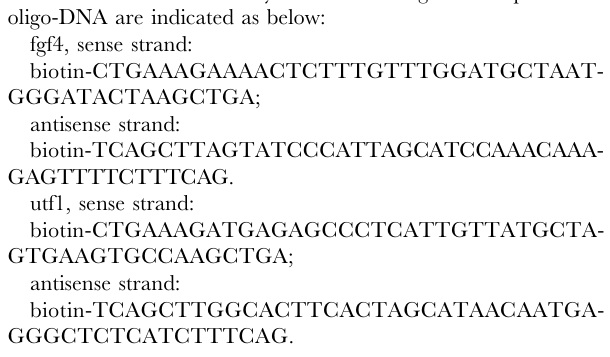
Figure S1 Schematic representation of 8 6 S/O-luc reporter plasmid. 8 6 S/O-luc carries eight copies of tandem fgf4 enhancer elements consisting of neighboring binding sites for Sox2 and Oct3/4. Figure S2 The effect of CARM1 overexpression on the expression of pluripotency-related genes in P19 cells. The relative mRNA levels of pluripotency markers were normalized to Gapdh. Figure S3 The effect of CARM1 knockdown with synthesized siRNA on the expression of pluripotency-related genes in P19 cells. The relative mRNA levels of pluripotency markers were normalized to Gapdh. Control: scrambled siRNA. Figure S4 MS/MS spectrum of the Sox2 peptide EHPDY- KYRdi-methylPR. GST-Sox2 methylated by GST-CARM1 was digested with trypsin and subjected to LC-MS/MS analysis. The MS/MS spectrum of a peptide corresponding to residues 106-115 of Sox2 showed that Arg113 was di-methylated. An asterisk indicates the methylated arginine. Figure S5 Specifically recognition of Sox2 peptide methylated at Arg113, by anti-methyl-Sox2 antibody. Un-methylated peptide KEHPDYXYRPRRKTKC (Arg113 is underlined) designated